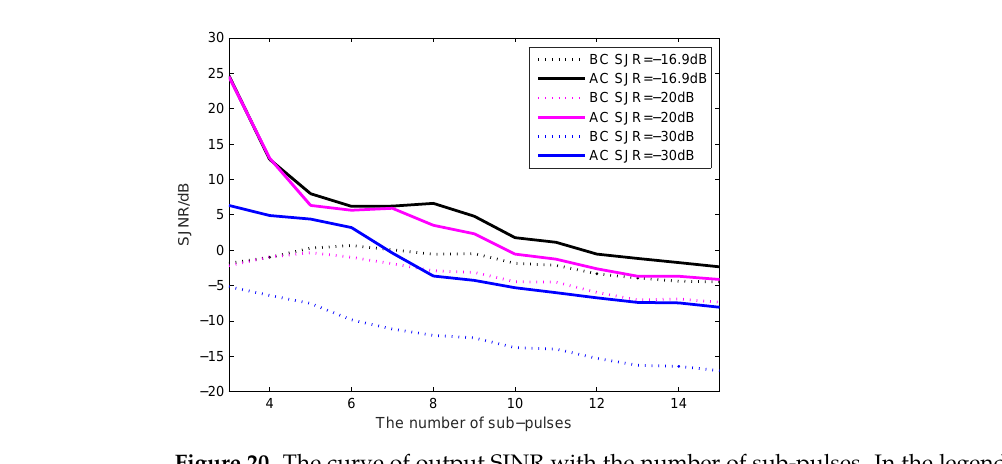
Figure 20. The curve of output SJNR with the number of sub-pulses. In the legend, “BC” denotes “before compensation”, while “AC” denotes “after